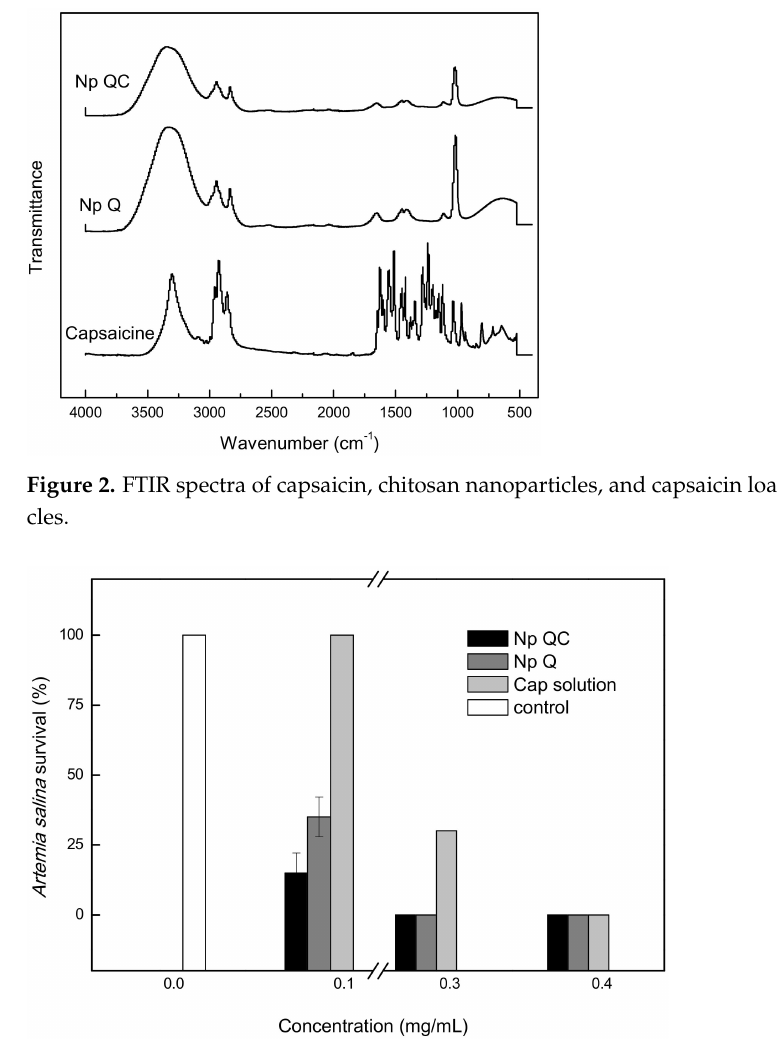
Figure 3. Acute toxicity of chitosan nanoparticles (Np Q), capsaicin loaded-chitosan nanoparticles (Np QC), and capsaicin solution on A. saline